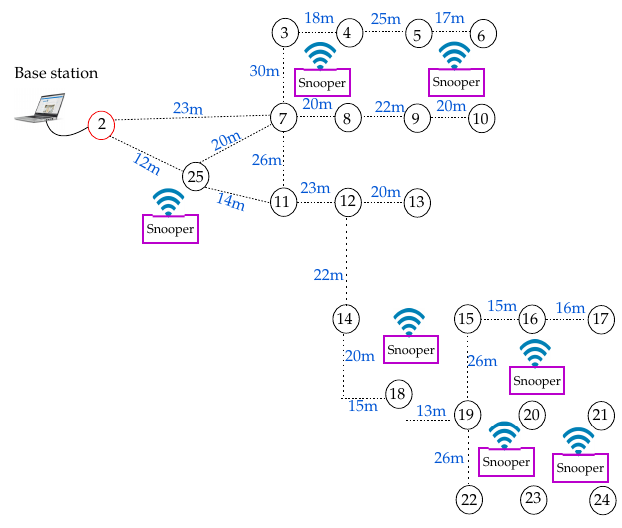
Figure 10. Field installation